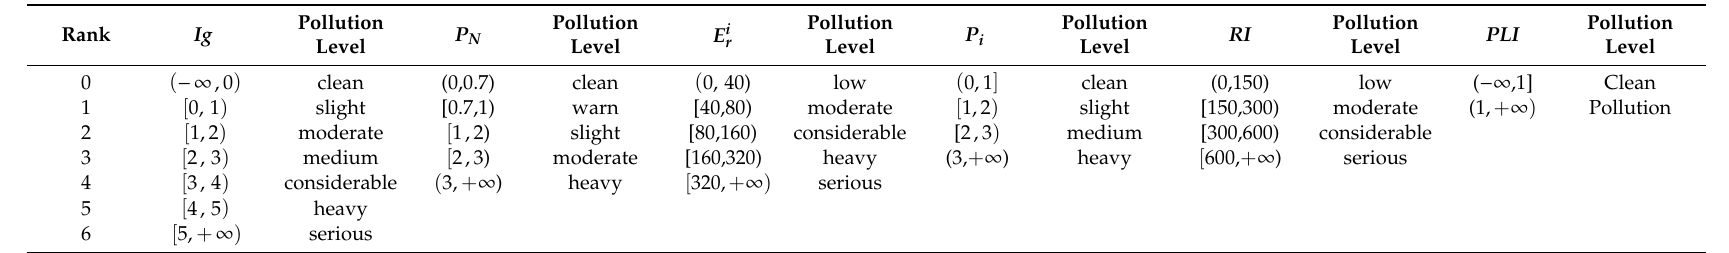
Table 2. Pollution levels of heavy metal based on di ff erent pollution indices in the sediment of the Shuanglong